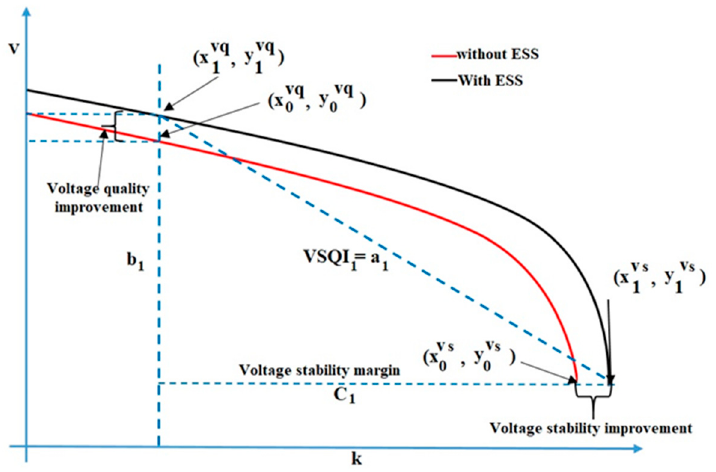
Figure 8. Voltage stability and quality index (VSQI) formulation from voltage stability curves [107].